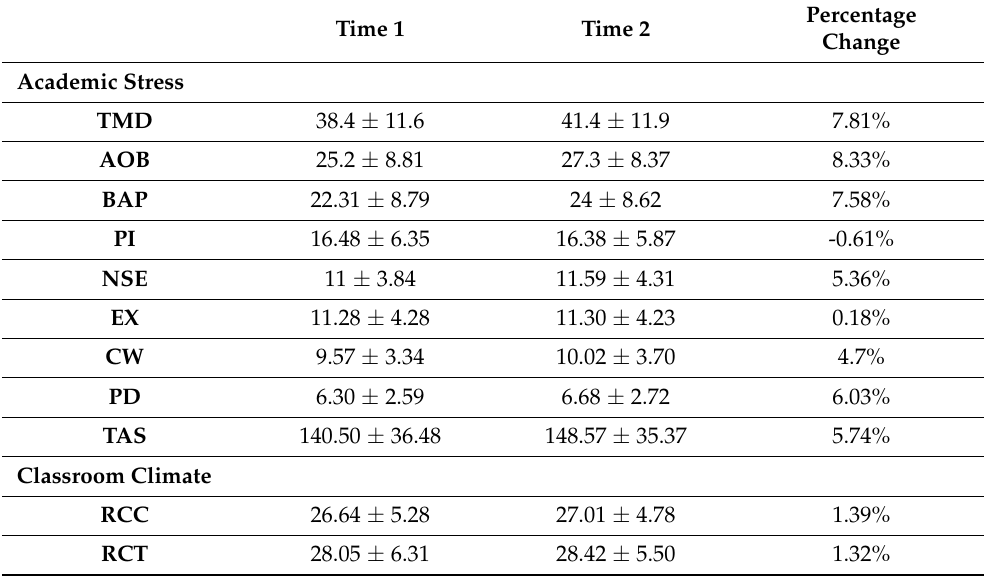
Table 2. Scores in academic stress and perceived classroom climate in Time 1 (before lockdown declaration) and Time 2 (after